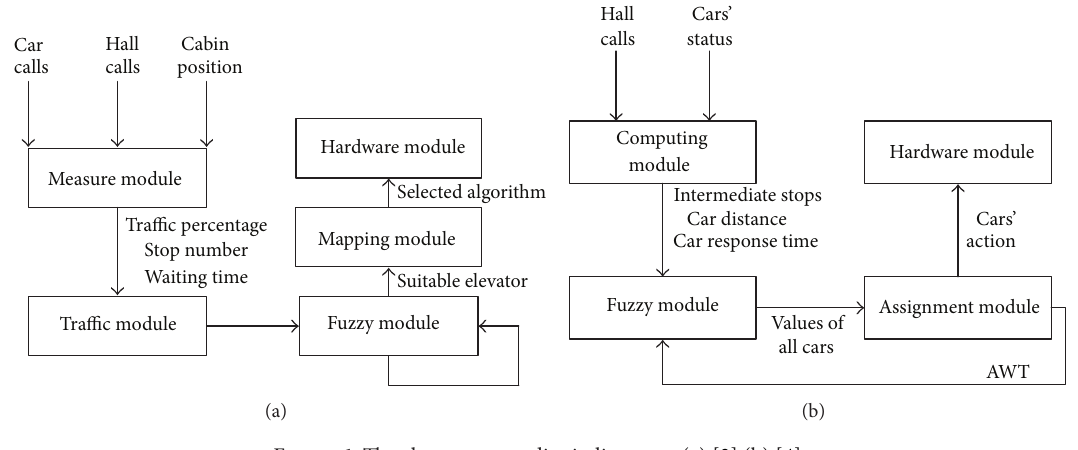
Figure 1: The closest two studies in literature (a) [2] (b)